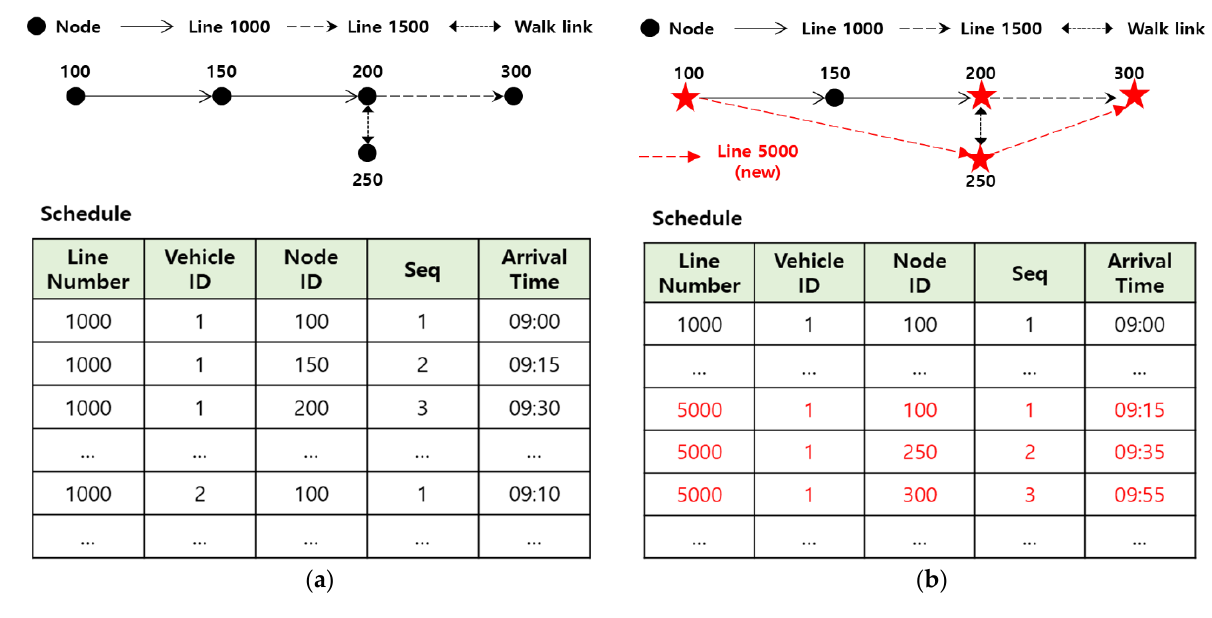
Figure 3. An example of an updated network: ( a ) before; ( b ) after.